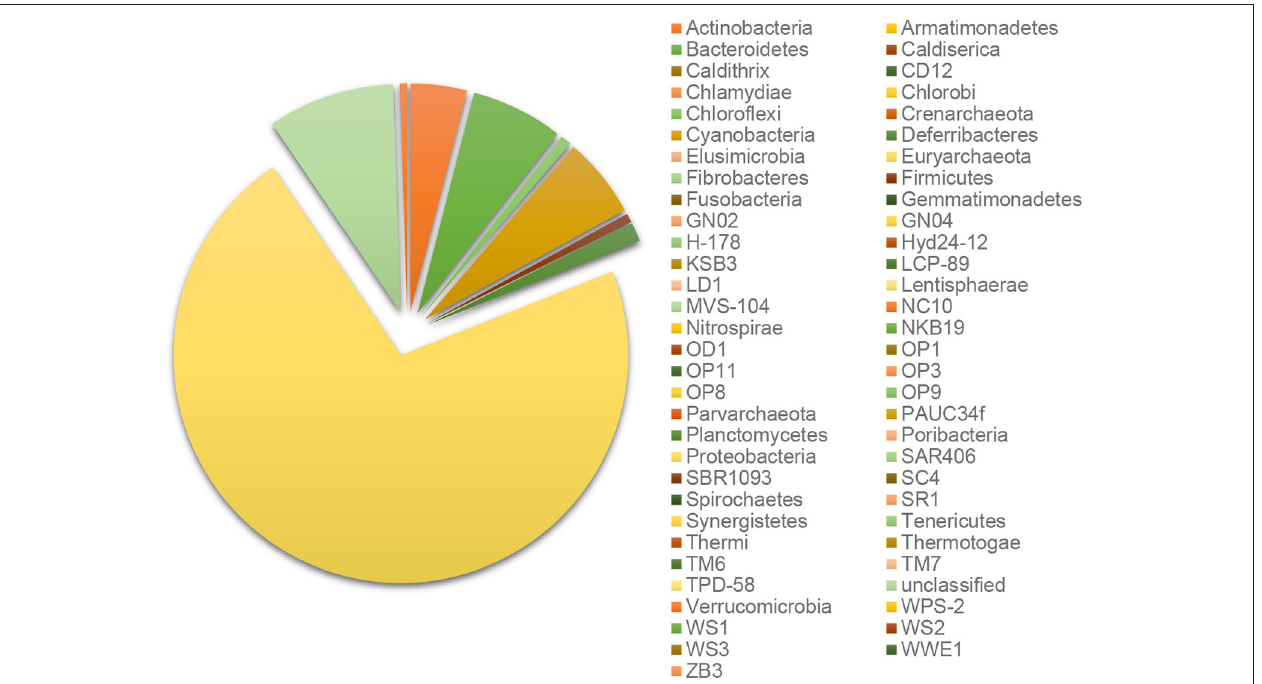
FIGURE 2 | Percent relative abundance at phylum levels.